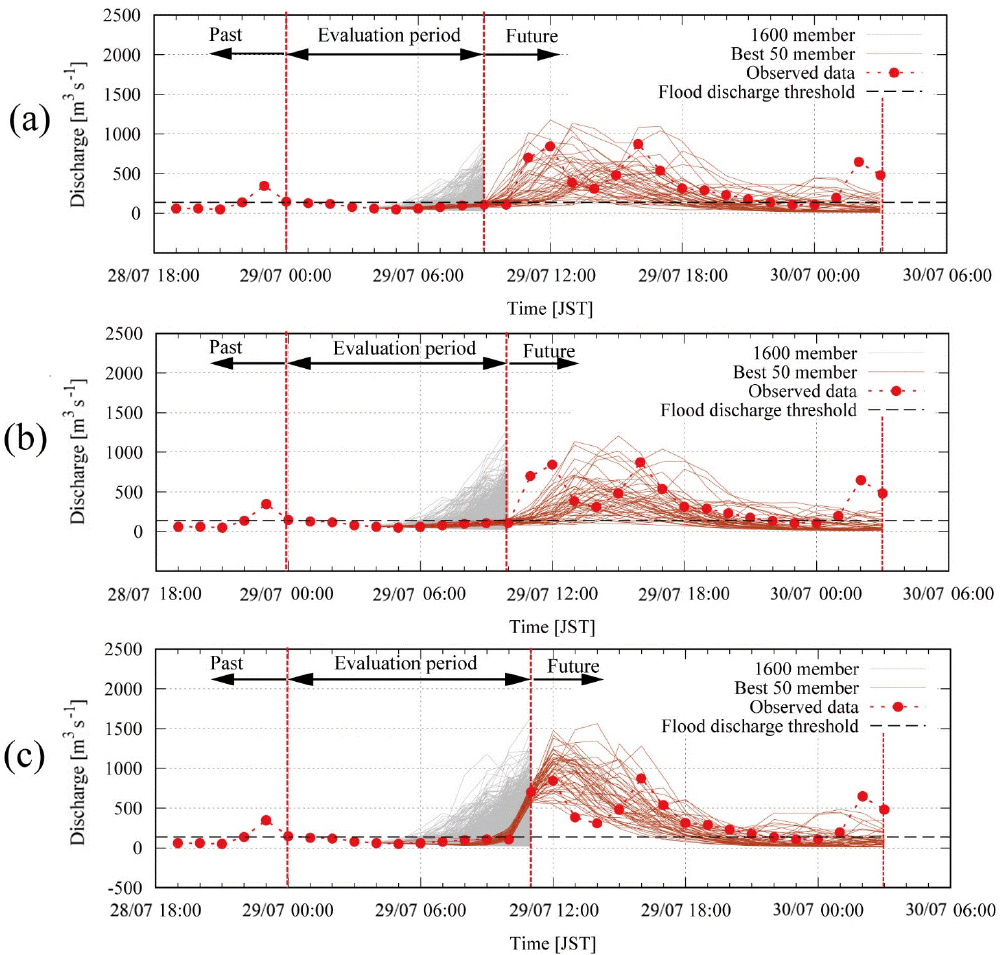
Figure 12. (a) Best 50 ensemble members (NSE > 0.24) selected from first 9h forecast, (b) best 50 ensemble members (NSE > − 0 . 04) selected from first 10h forecast and (c) best 50 ensemble members (NSE > 0.92) selected from first 11h